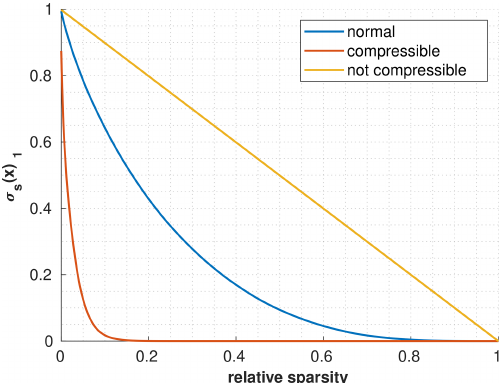
Figure 1. Visualization of the compressibility of emission fields by plotting σ s ( x ) 1 over all s . The more hyperbolic the curve is, the more compressible the emission